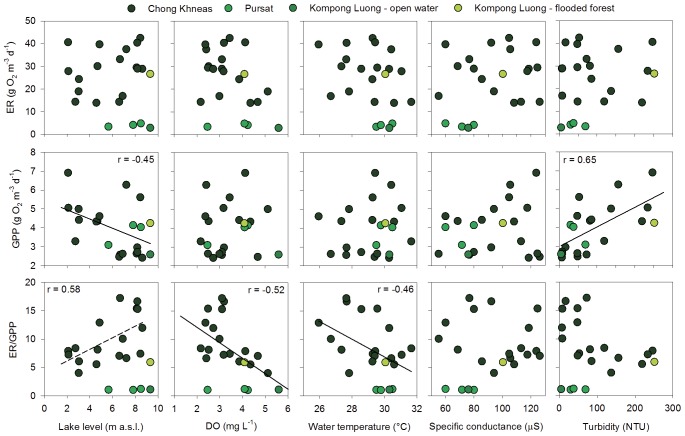
Correlations between Tonle Sap ecosystem metabolic properties and physical drivers.Data points are monthly averages for each site and year. Dissolved oxygen, water temperature, specific conductance, and turbidity are from concurrent measurement at each site using data sondes. Lines indicate significant Pearson’s correlations following a Student's t-distribution (α = 0.05). The dashed line indicates that only data from the Chong Khneas site were included in the correlation analysis.